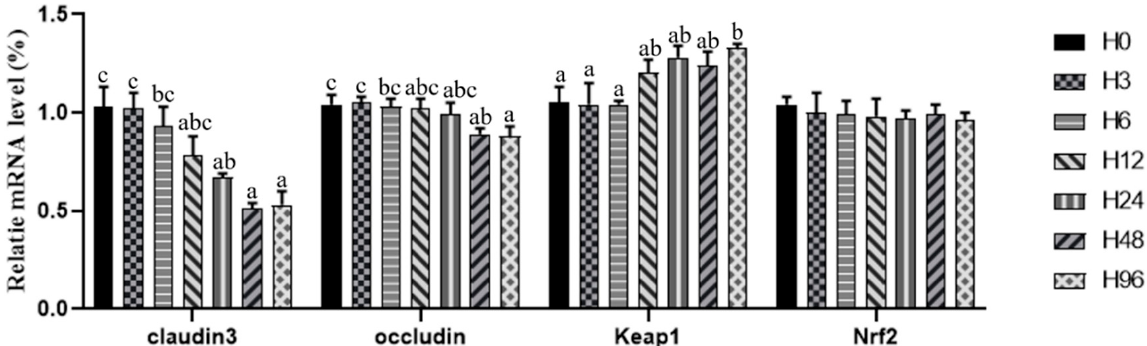
Figure 5. Effect of dietary histamine content on the relative mRNA expression of tight junction proteins and oxidative stress-related factors in the hindgut of the hybrid grouper. Keap1, Kelch-like ECH-associated protein 1; Nrf2, nuclear factor erythroid 2-related factor 2. Bars represent means ± SE of three replications. Different superscript letters in the bars indicate a significant difference among treatments by Tukey’s test ( p < 0.05).